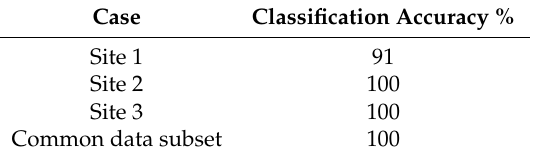
Table 2. Classification accuracy results.